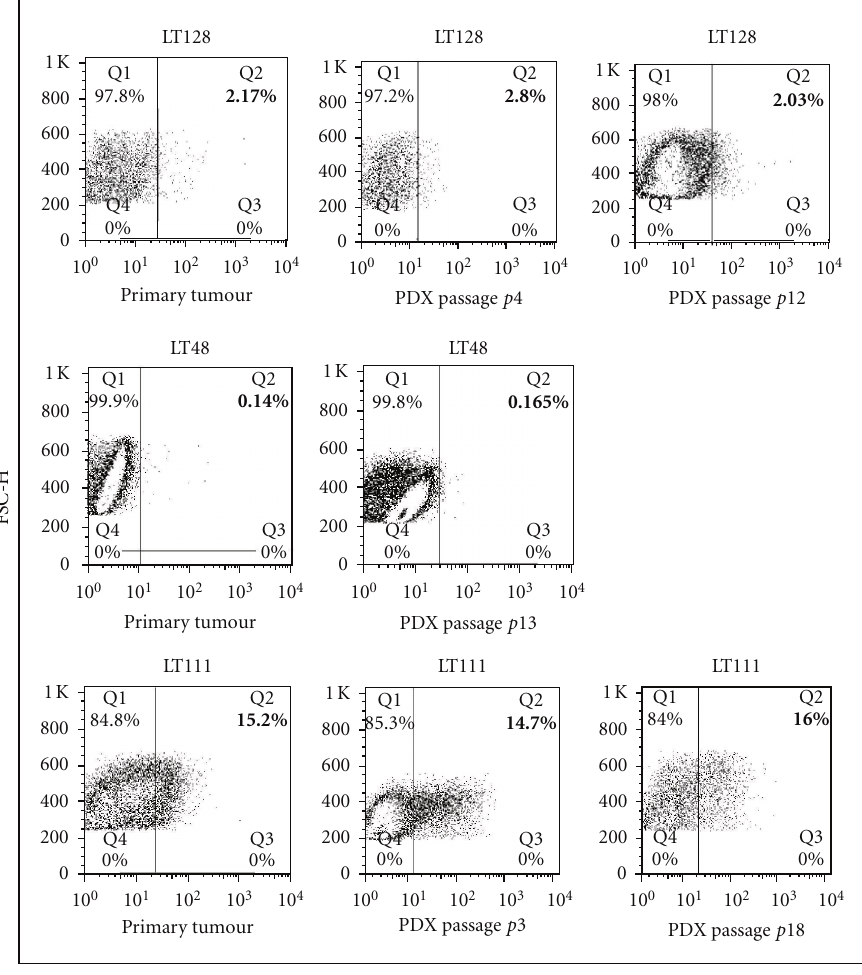
Figure 2: Frequency of CD133 + cells in primary tumors is maintained in PDXs during passaging in mice independently of their initial content. Dot plots showing that the percentage of CD133 + cells, previously demonstrated to display stem-like features and to be spared by cisplatin treatment [REF], is similar in the primary tumor and in PDXs. CD133 + cells levels remain stable also after several passages in immunocompromised mice in PDX models established from low, intermediate and high CD133-expressing tumors (LT48, LT128, LT111 resp.). p = number of serial transplant in mouse. FACs analysis of CD133 expression was performed with CD133/1-phycoerythrin antibody (50 μ g/mL; AC133 clone; Miltenyi